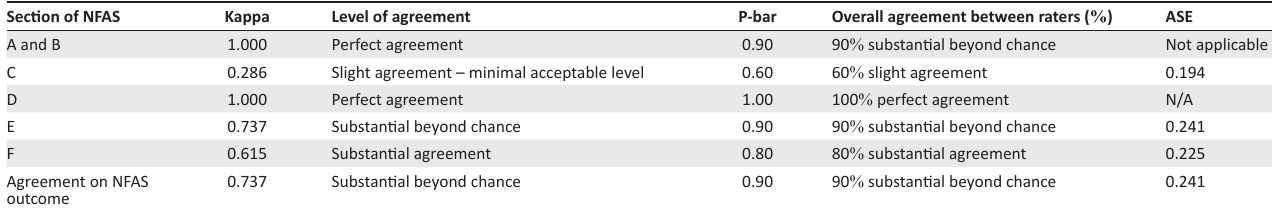
TABLE 5: Inter-rater reliability of sub-sections and diagnostic outcome of the NFAS ( n = 10). Section of NFAS Kappa P-bar Overall agreement between raters ( % )